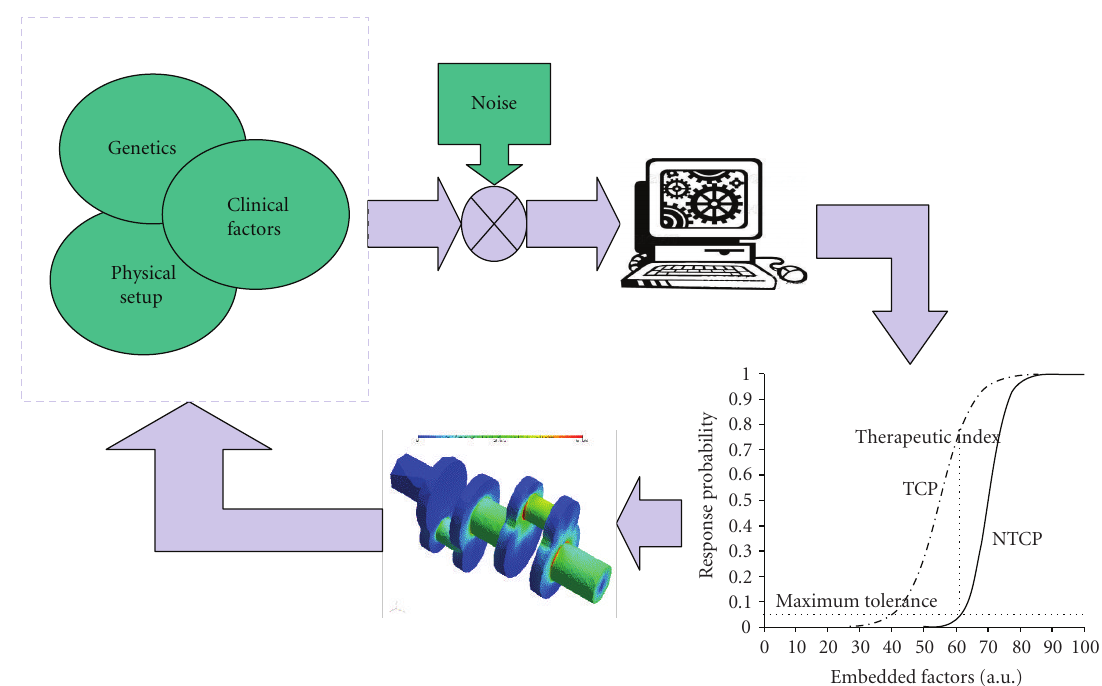
Figure 3: The datamining understanding of these heterogeneous variables interactions could be fed back into the treatment planning system to improve patient’s